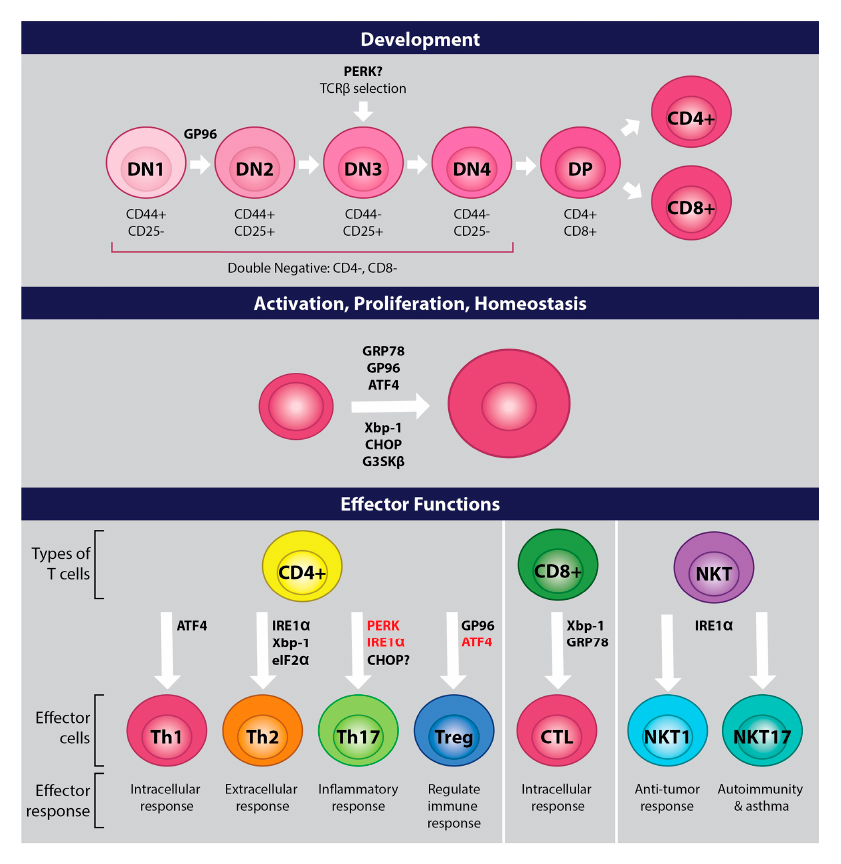
Figure 3. Roles for UPR molecules in T cells. UPR associated proteins play important roles at all stages in the life of a T cell. Proteins in black appear to play a direct role in T cells, while proteins in red promote effector functions when the T cell is placed in a less than optimal environment (i.e., reduced glucose metabolism, amino acid deprivation, oxidizing environment, etc.). Proteins with a question